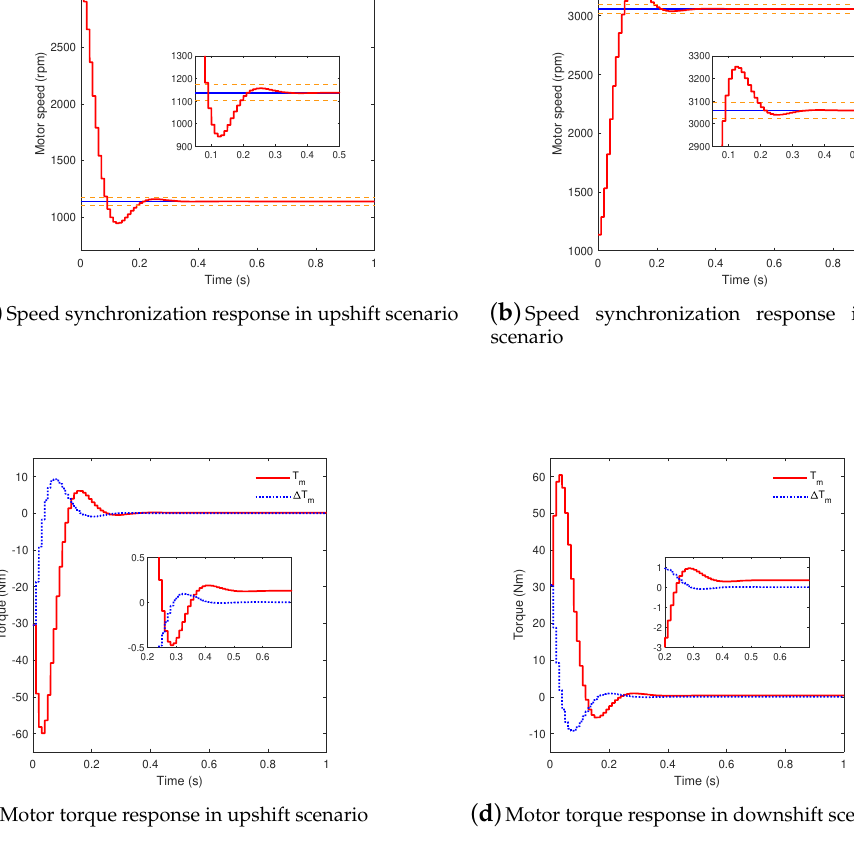
Figure 6. The 1–3 upshift and downshift process with the desired poles. ( a ) Speed synchronization response in upshift scenario; ( b ) Speed synchronization response in downshift scenario; ( c ) Motor torque response in upshift scenario; ( d ) Motor torque response in downshift